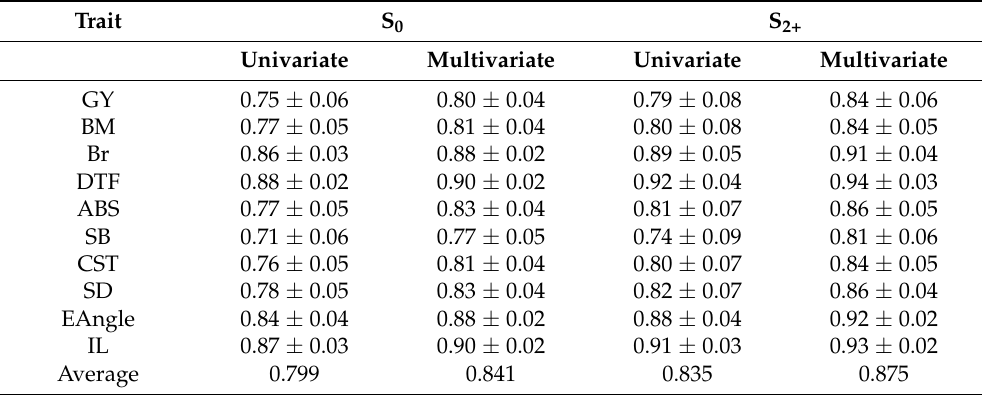
Abbreviations in table: GY, single plant grain yield; BM, dry whole plant biomass at maturity; Br, number of basal branches (square root transformed); DTF, days to flower; ABS, ascochyta blight score; SB, stem buckling; CST, compressed stem thickness; SD, stem diameter; EAngle, early stem angle from horizontal; IL, internode